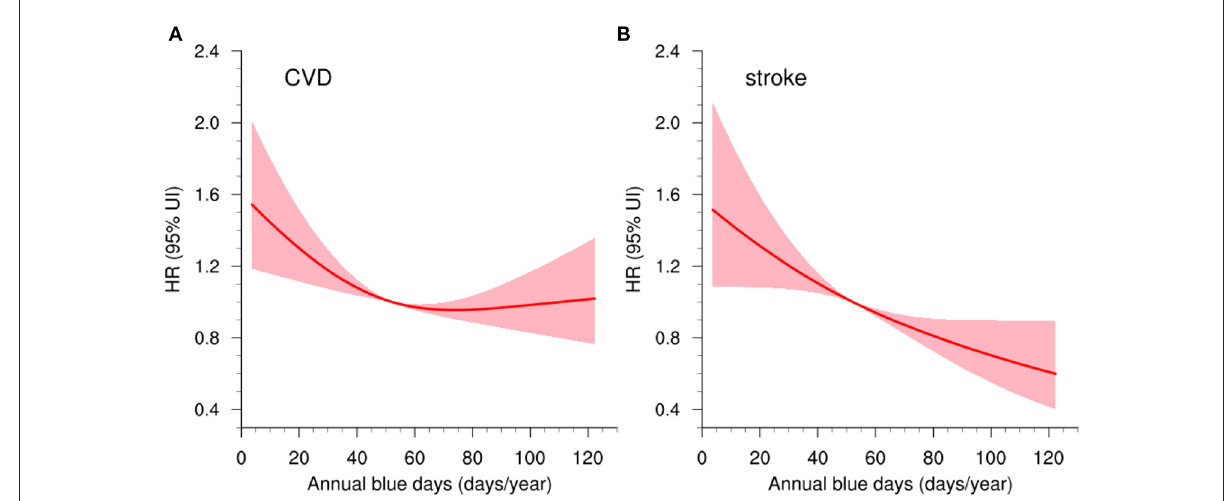
FIGURE3 Concentration–response curves (red lines) with 95% CIs (shadings) of blue day exposure (days/year) and (A) fatal or nonfatal CVD, and (B) fatal or nonfatal stroke. CVD, cardiovascular disease.